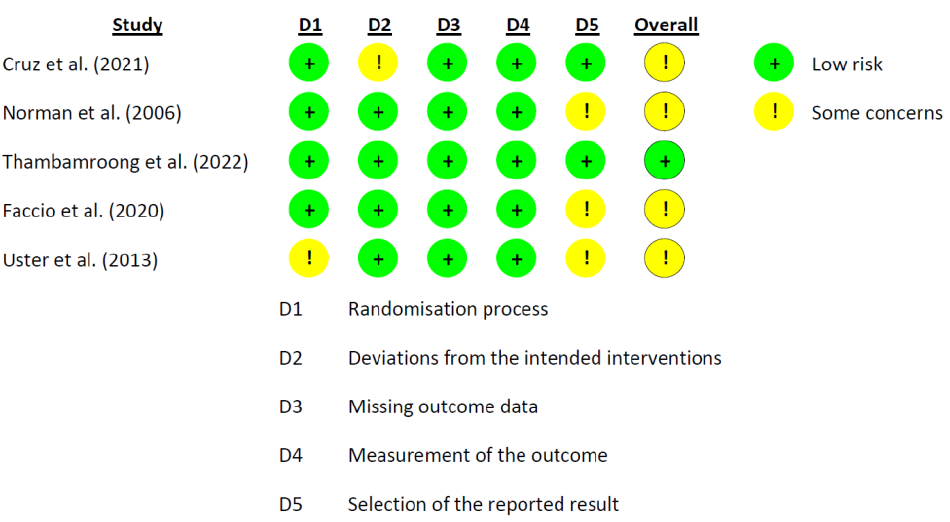
Figure 2. Graph of RoB 2.0 for each study according to the five domains defined by Cochrane for per protocol studies [41,42,52–54].